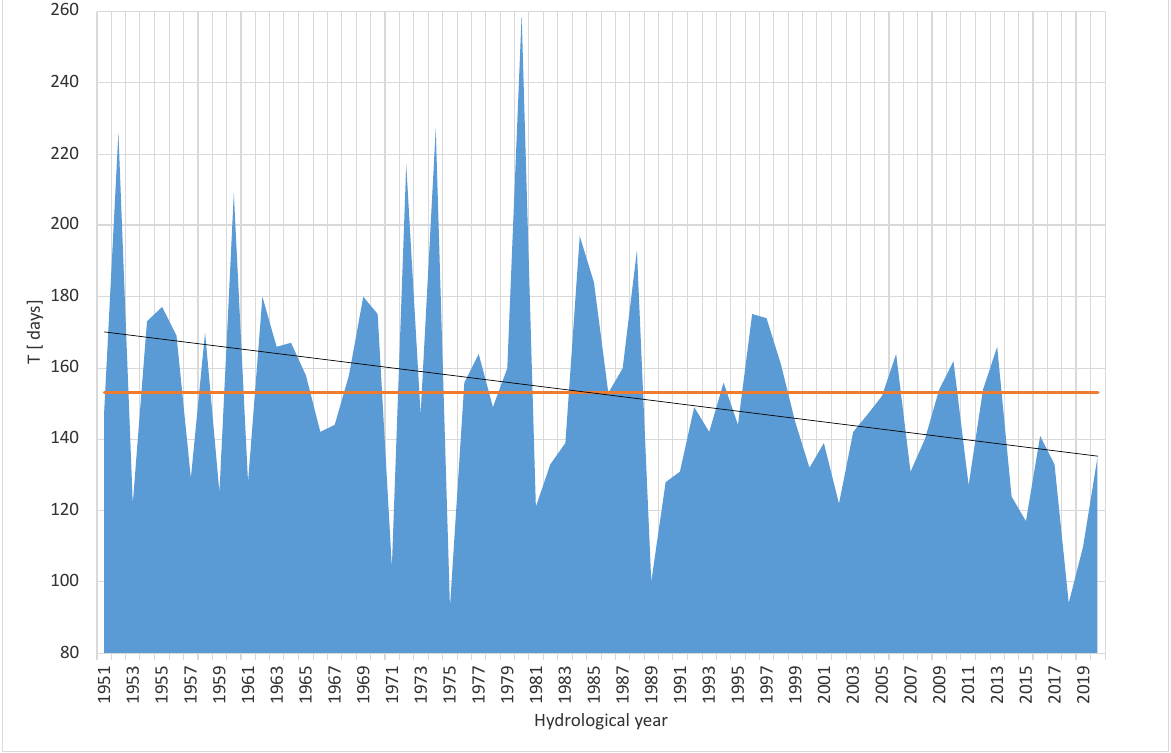
Figure 12. TPO changeability in the period of 1951–2020 at the Narewka gauging station.